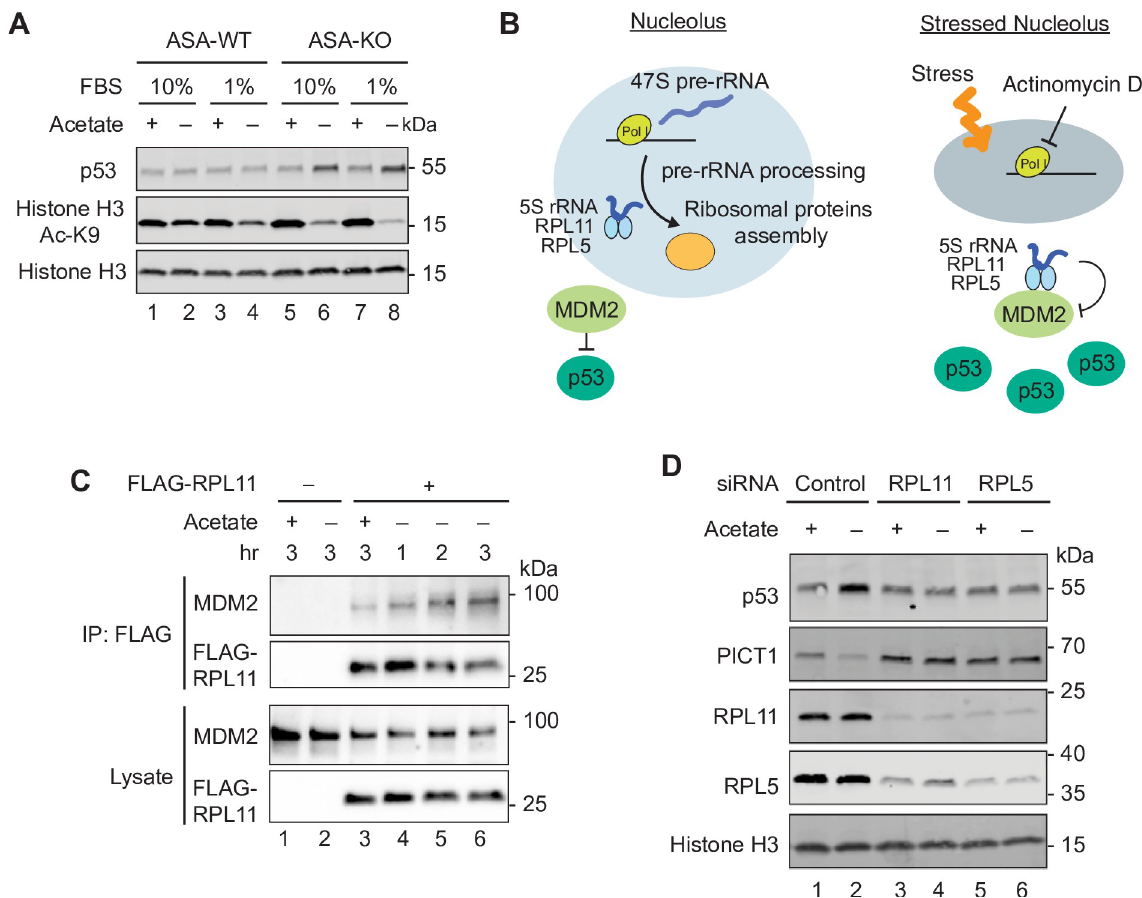
Fig 4. Ribosomal protein–dependent p53 activation by acetyl-CoA depletion. (A) Immunoblotting for p53 levels in ASA-WT and ASA-KO cells cultured in 10% or 1% FBS containing media with or without acetate for 4 hours. Ac K9 and total histone H3 are also shown. (B) Schematic representation of the nucleolus as an organelle for ribosome biogenesis (left) and the stressed nucleolus that induces p53 stabilization through the inhibitory interaction between the 5S rRNA-RPL11-RPL5 complex and MDM2. (C) Immunoprecipitation with FLAG-RPL11 and immunoblotting for MDM2 and FLAG-RPL11 in ASA-KO cells cultured in 1% FBS containing media with or without acetate for the indicated hours. (D) Immunoblotting for p53 levels in ASA-KO cells pretreated with indicated siRNAs and cultured in 1% FBS containing media with or without acetate for 4 hours. Histone H3 is shown as a loading control. Ac, acetylated; acetyl-CoA, acetyl-coenzyme A; ASA-KO, acetate-supplemented ACLY knockout; ASA-WT, acetate-supplemented ACLY wild type; FBS, fetal bovine serum; rRNA, ribosomal RNA; siRNA, small interfering